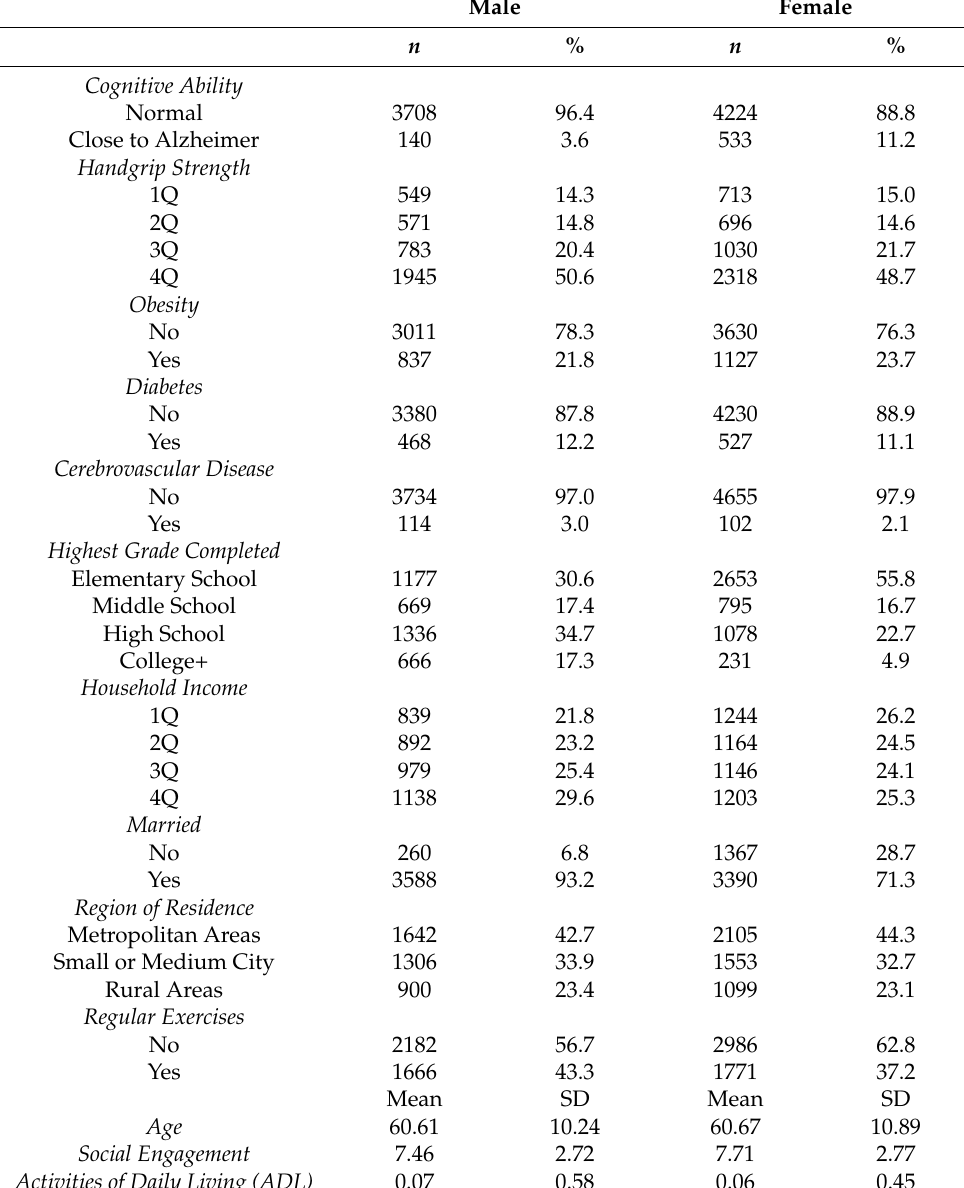
Table 1. Sample Means and Standard Deviations by Gender for Variables Used in an Analysis of Cognitive Impairment: Korean Longitudinal Study of Aging (KLoSA)